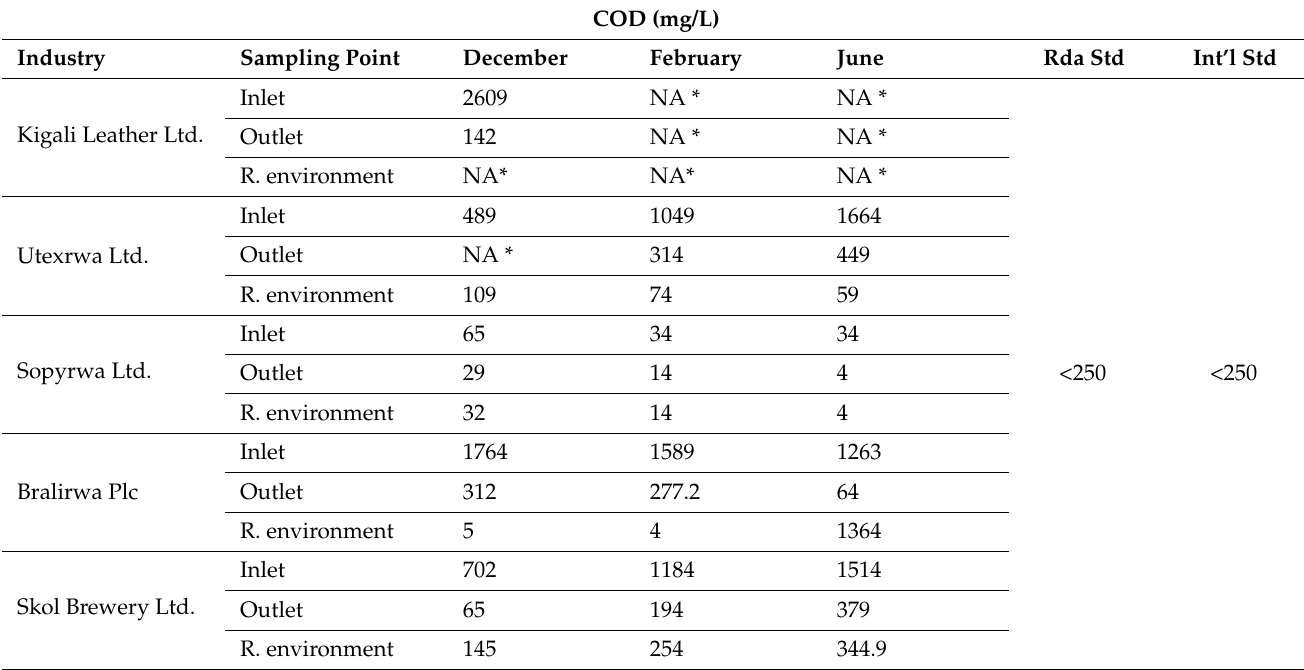
Table 4. COD results for the selected